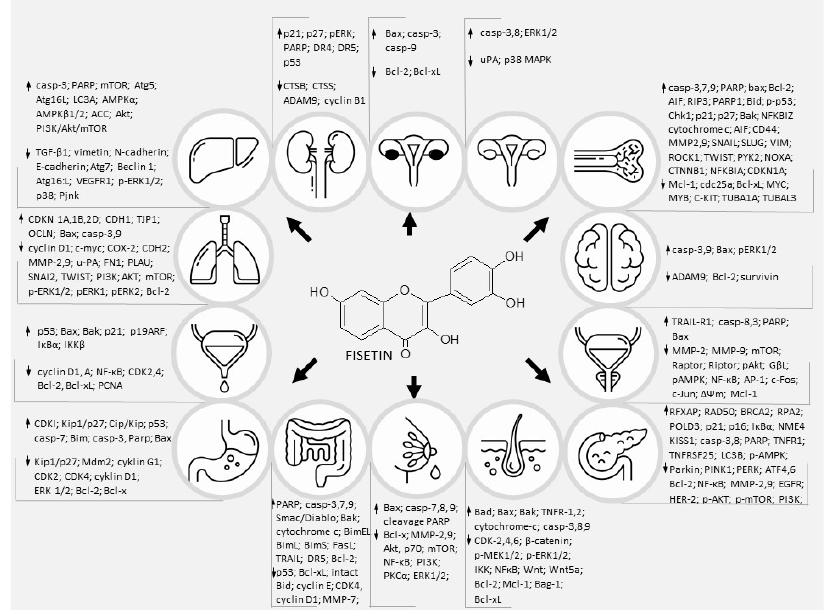
Figure 3. The multilevel, ultracellular effects of fisetin on major signalings that are involved in var- ious cancers. various